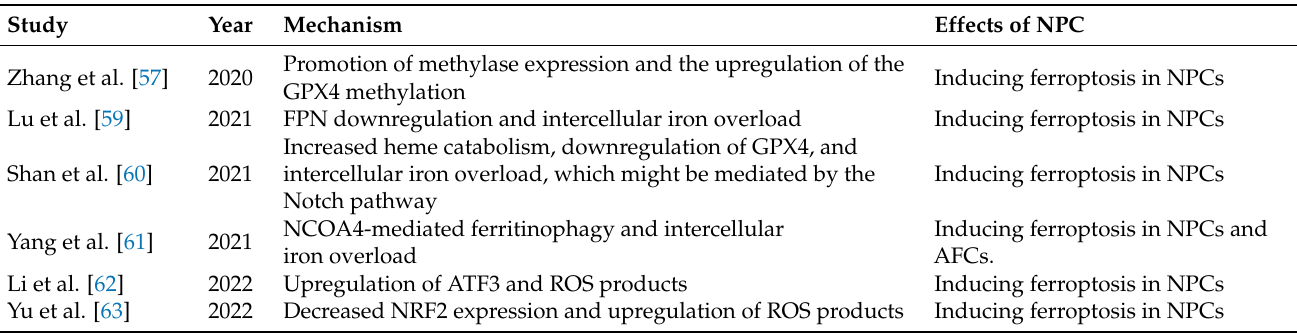
Table 3. Mechanism of ferroptosis in